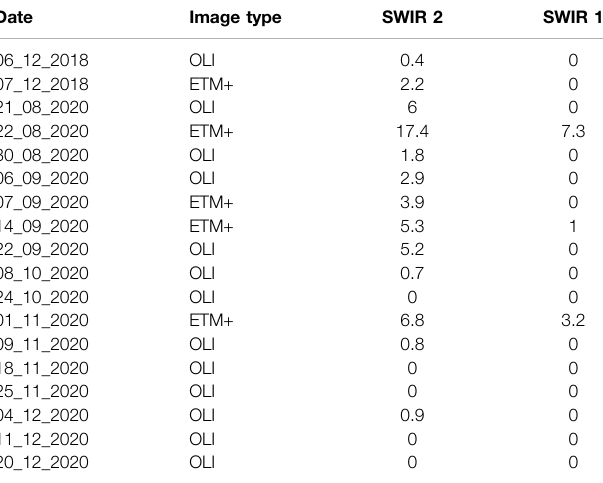
TABLE1| Date,imagetype,andthermalradianceofSWIRbands1(band5and6 for Landsat ETM+ and OLI, respectively) and 2 (band 7for Landsat ETM+ and OLI) in W/m 2 μ msr for the nested crater of Peteroa volcano.